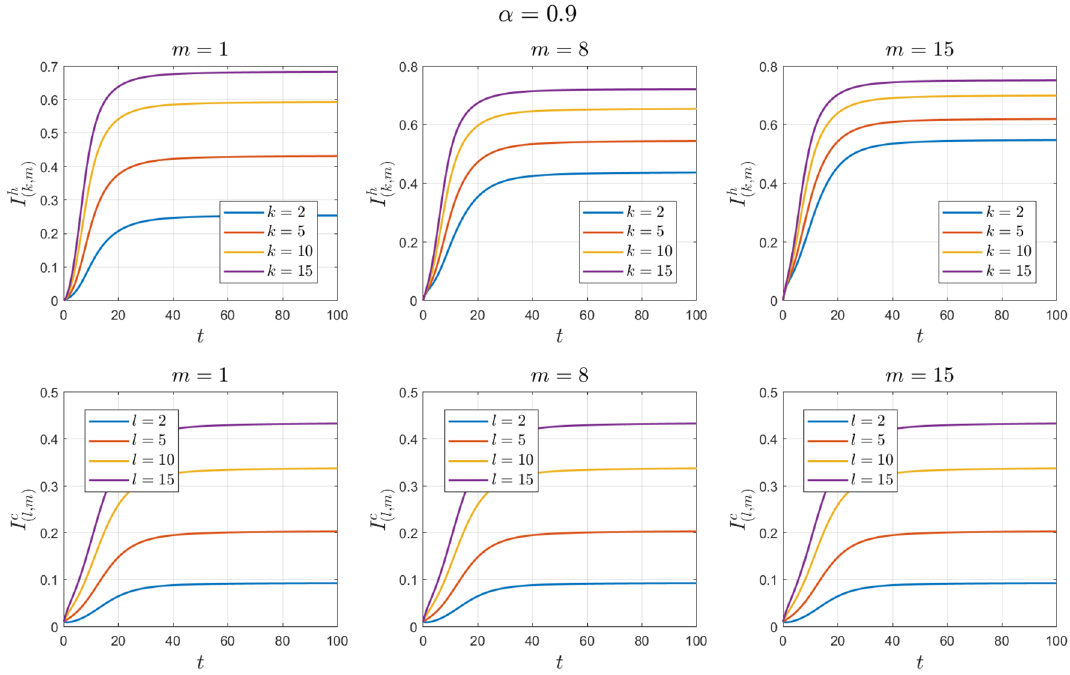
Figure 5. Numerical solutions of Example 2 for α = 0.9